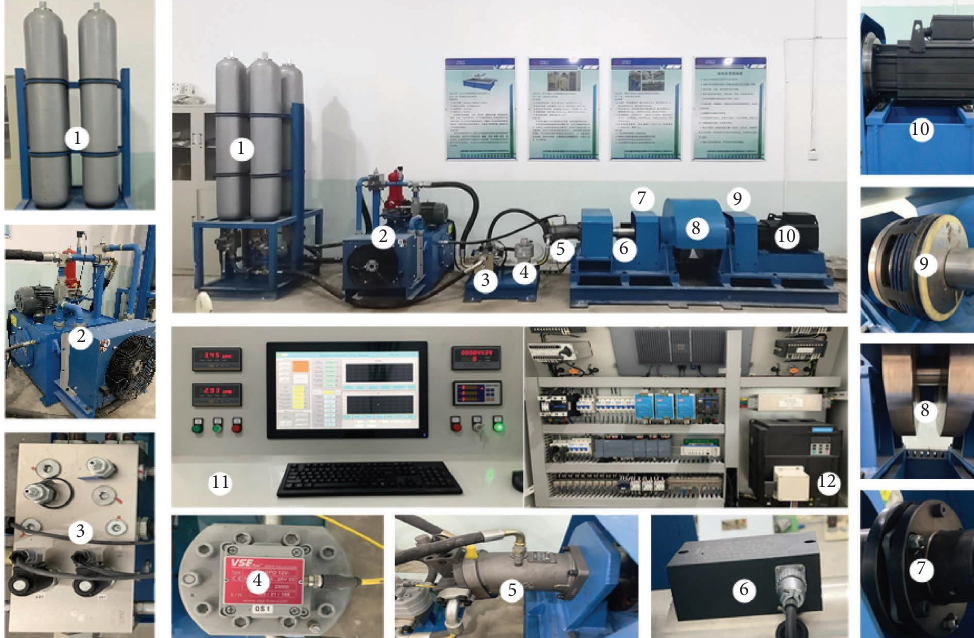
Figure 15: Brake energy recovery test bench. 1, a group of accumulators; 2, units for oil pump motors; 3, integrated valve blocks; 4, fowmeter; 5, energy recovery pump/motor; 6, rotational speed and torque sensors; 7, clutch 1; 8, fywheel; 9, clutch 2; 10, motor; 11, operation panel; 12, industrial